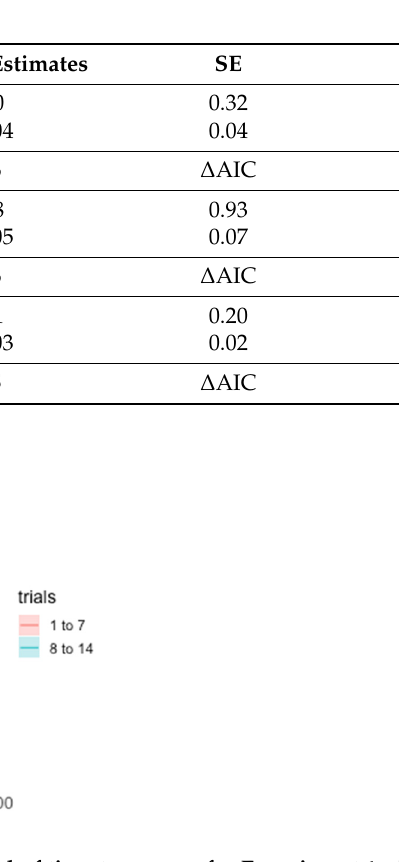
Table 1. Model results for Experiment 1—within modality ‘sameness’ assay. All models were created with behavioral data from training trials. ∆ AIC is the difference between the AIC of the model with and without trial number as a predictor. Positive ∆ AIC indicates the model shown had a higher AIC value and is a worse model fit than the model without trial number. Including trial number in these models did not significantly improve model fit, indicating P. marginemaculatus did not improve over training trials.